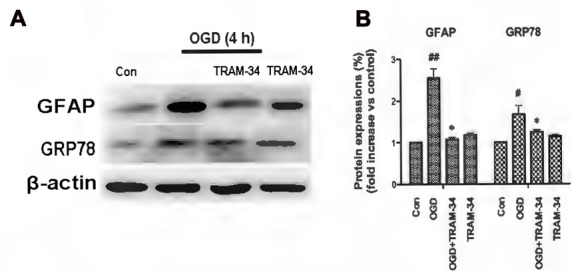
Blockade of KCa3.1 attenuated OGD-induced astrogliosis and endoplasmic reticulum (ER) stress in primary astrocytes. (A) Whole-cell lysates were collected to evaluate the expression of GFAP and 78 kDa glucose-regulated protein (GRP78) in primary astrocytes by western blotting after 4 h OGD. β-Actin was used as a loading control. (B) The bar graphs represent the ratio of GFAP/β-actin and GRP78/β-actin, normalized to the control (n = 3–4). β-Actin was used as a loading control. The data are expressed as means ± SEM. #p < 0.05, ##p < 0.01 vs. control; *p < 0.05 vs. OGD. Con, control; OGD, oxygen–glucose deprivation.